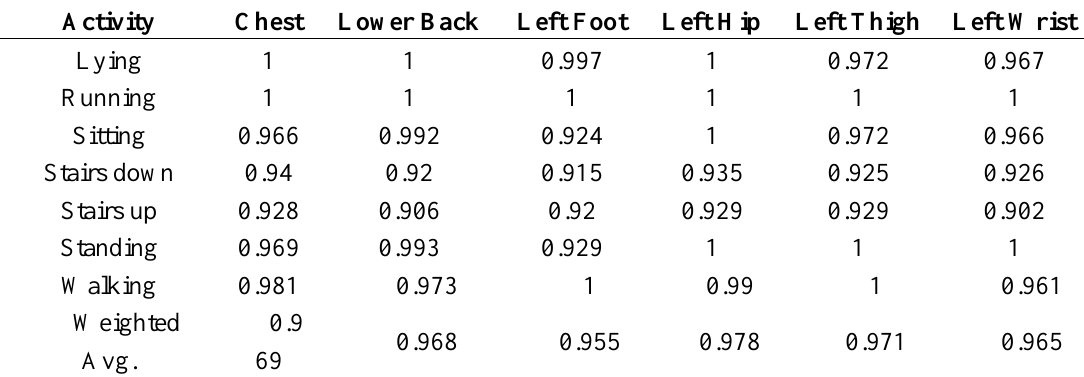
F-measure values for each